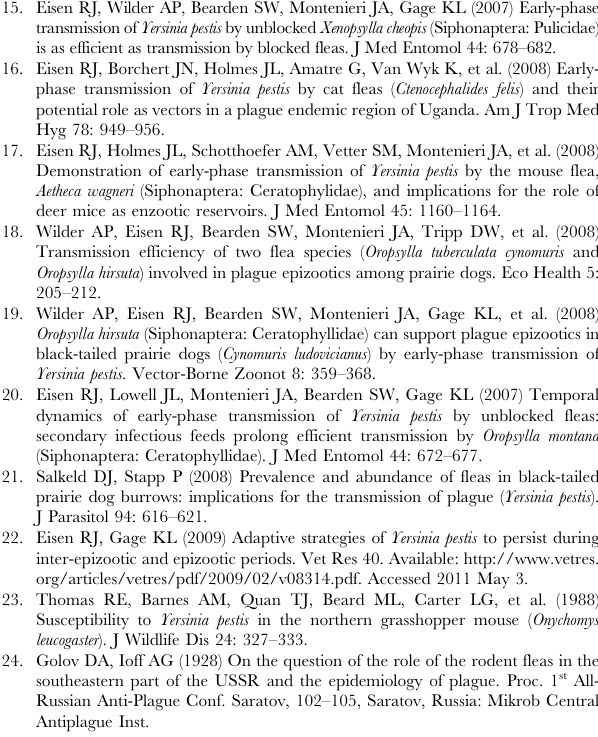
feed infection cycle (blue), infectious, questing flea reservoir (green), and infectious carcasses (orange). (TIF) Figure S2 Flow chart for the flea submodel. The relationship between the booster-feed infection cycle (blue) and infectious flea reservoir (green) is highlighted. (TIF) Table S1 Alternate flea parameter values. Parameter values for the prairie dog flea O. tuberculata cynomuris . Other flea species are provided for comparison. Text S1 Alternate flea submodel which prevents the buildup of infectious, questing